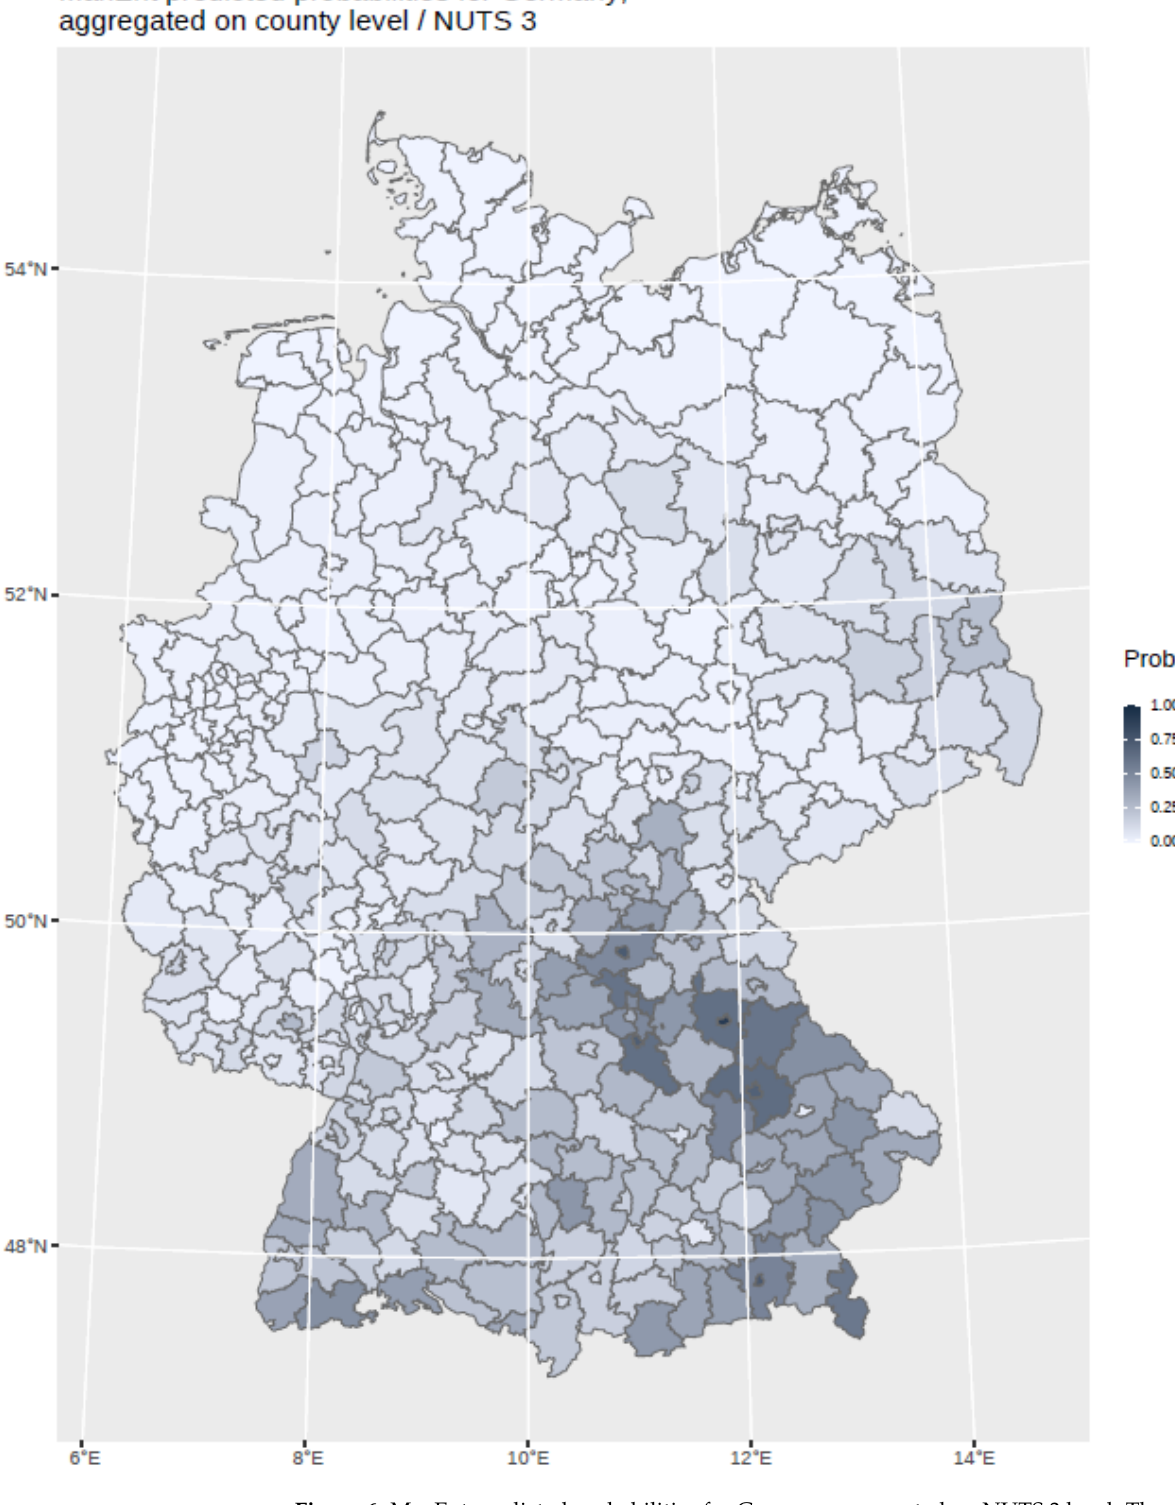
Figure 6. MaxEnt predicted probabilities for Germany aggregated on NUTS 3 level. The probability is displayed in different grey shades.